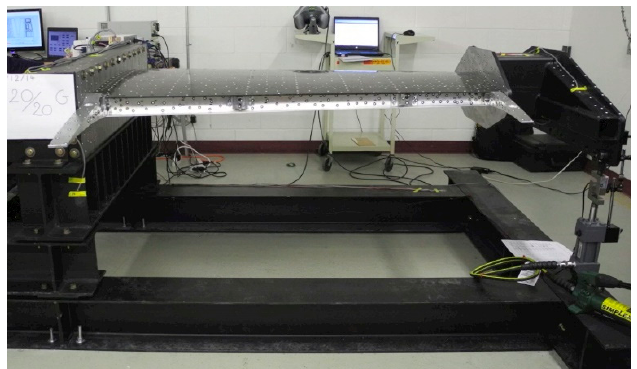
Figure 3. The wing on the bench test at Ecole de Technologie Supérieure (ETS) during 1g structural static test.